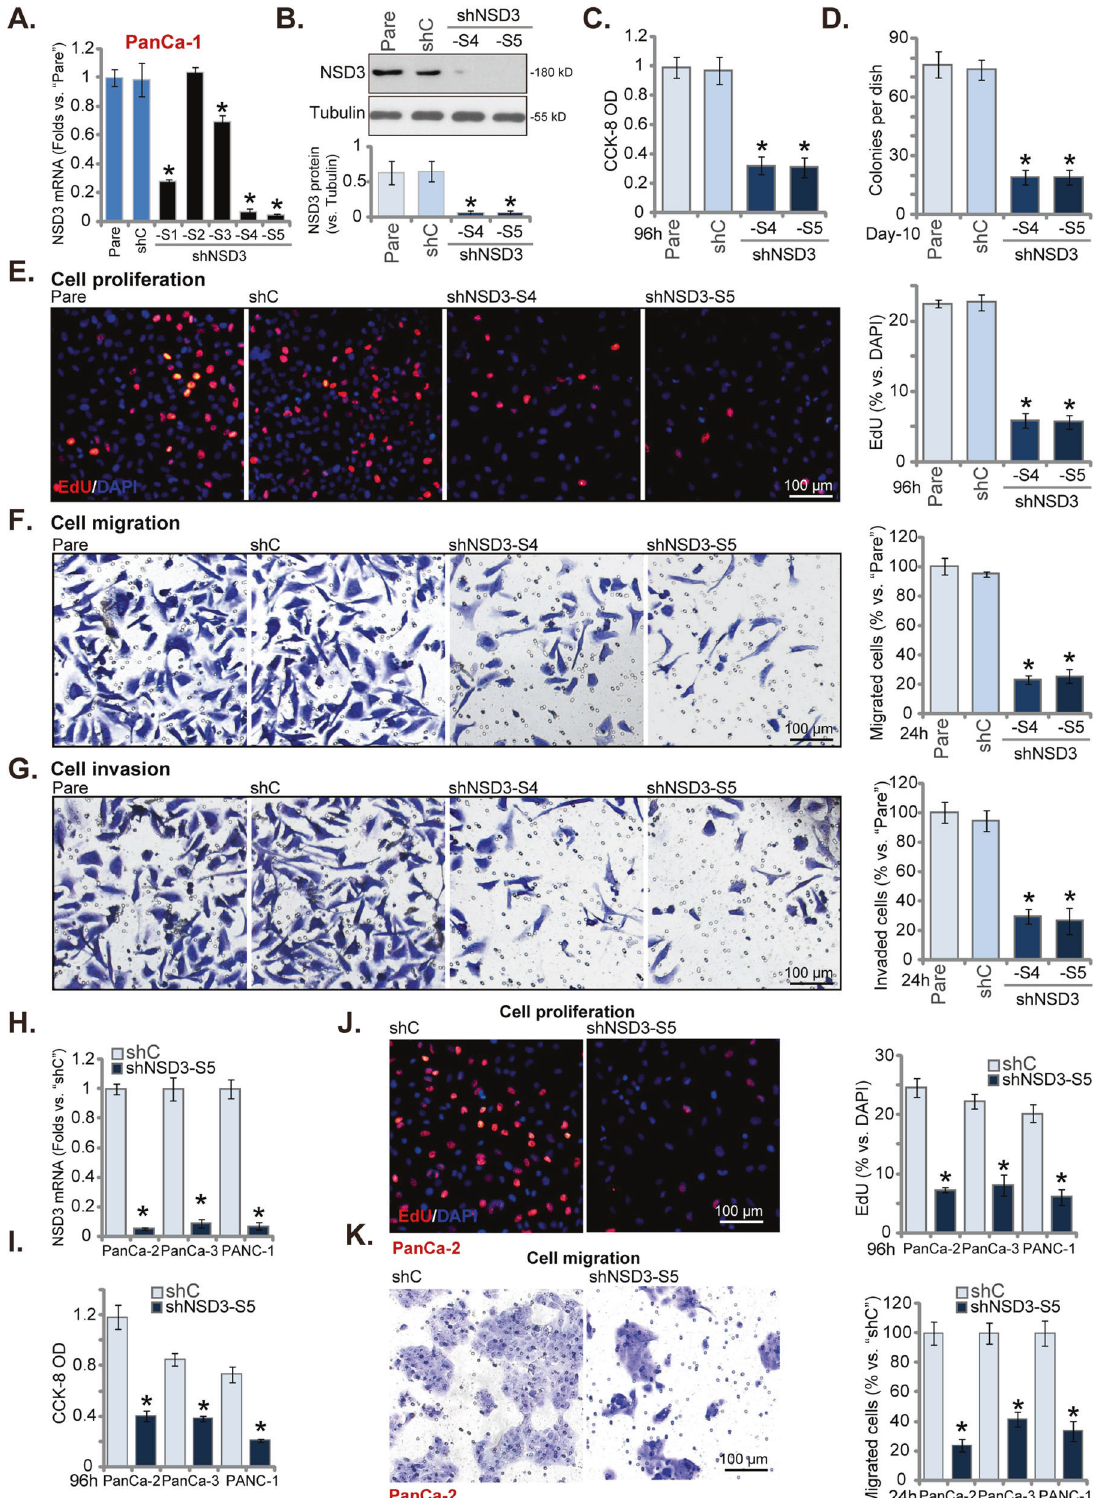
Fig. 2 NSD3 shRNA inhibits pancreatic cancer cell survival, proliferation and migration. The primary human pancreatic cancer cells (PanCa- 1/-2/-3, derived from three different patients) or PANC-1 cells, stably expressing applied NSD3 shRNA or control shRNA ( “ shC ” ), were established. Expressions of NSD3 mRNA and listed proteins were examined by qRT-PCR ( A , H ) and western blotting ( B ) assays. Cells were further cultured for applied time periods, cell viability (CCK-8 assays, C , I ), colony formation ( D ) and proliferation (EdU staining assays, E , J ), as well as cell migration ( “ Transwell ” assays, F , K ) and invasion ( “ Matrigel Transwell ” assays, G ) were tested. “ Pare ” stands for the parental control cells. Data were presented as mean ± standard deviation (SD, n = 5). * P < 0.05 vs. “ shC ” cells. Experiments in this fi gure were repeated fi ve times with similar results obtained. Scale bar = 100 μ m ( E – G , J , K ).